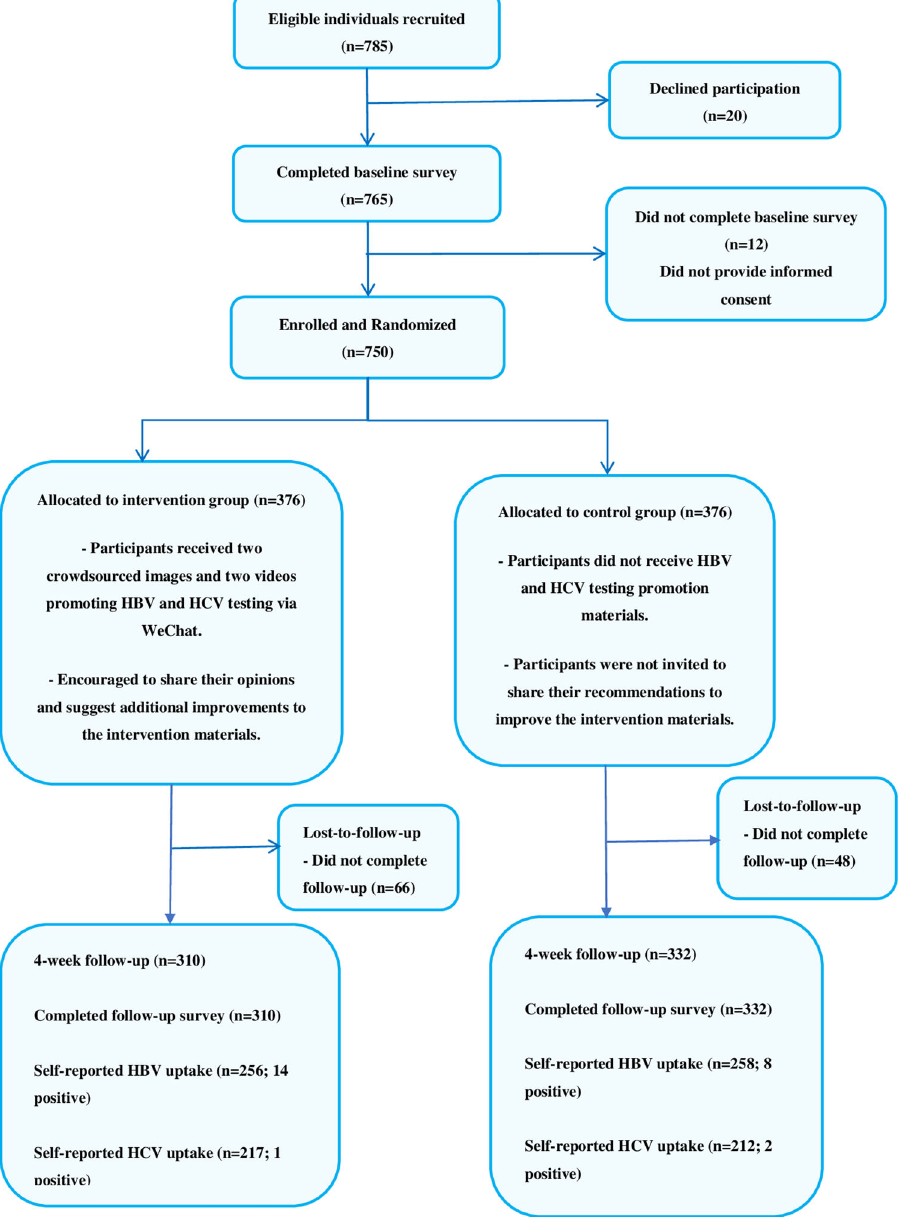
Fig. 1 Study recruitment process. Flow chart showing participant recruitment, number of participants randomized to the intervention and control groups respectively, and number of participants retained in each group at